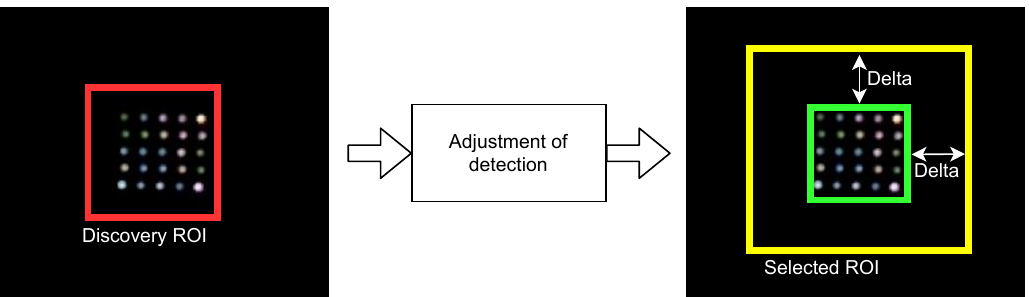
Figure 5. Example of operation of the adjustment of